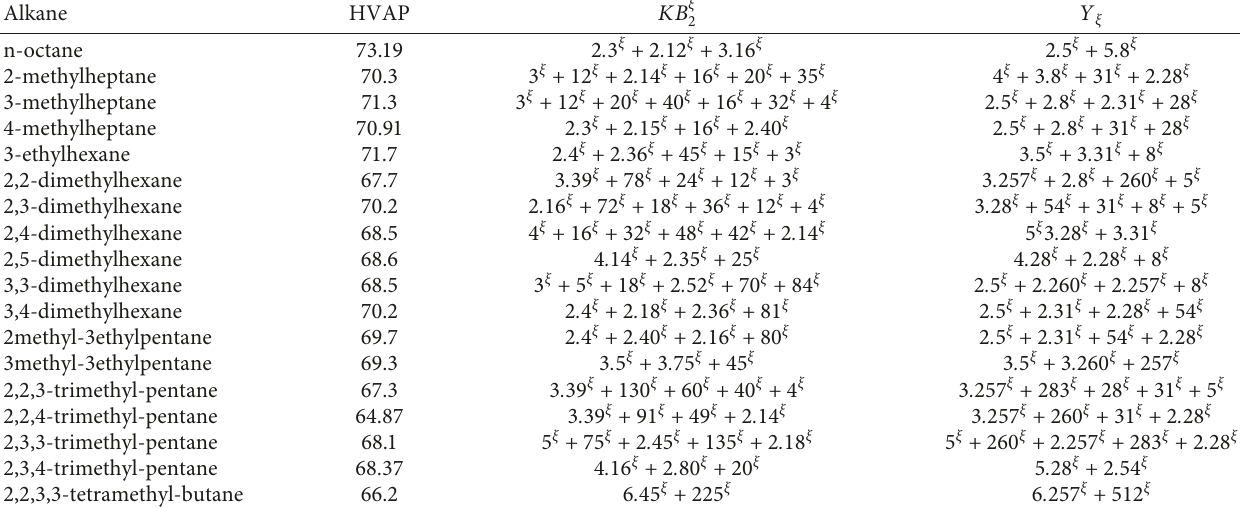
Table 10: Experimental values of HVAP and the corresponding values of generalized form of second Kulli–Basava index and generalized power-sum-connectivity index of octane